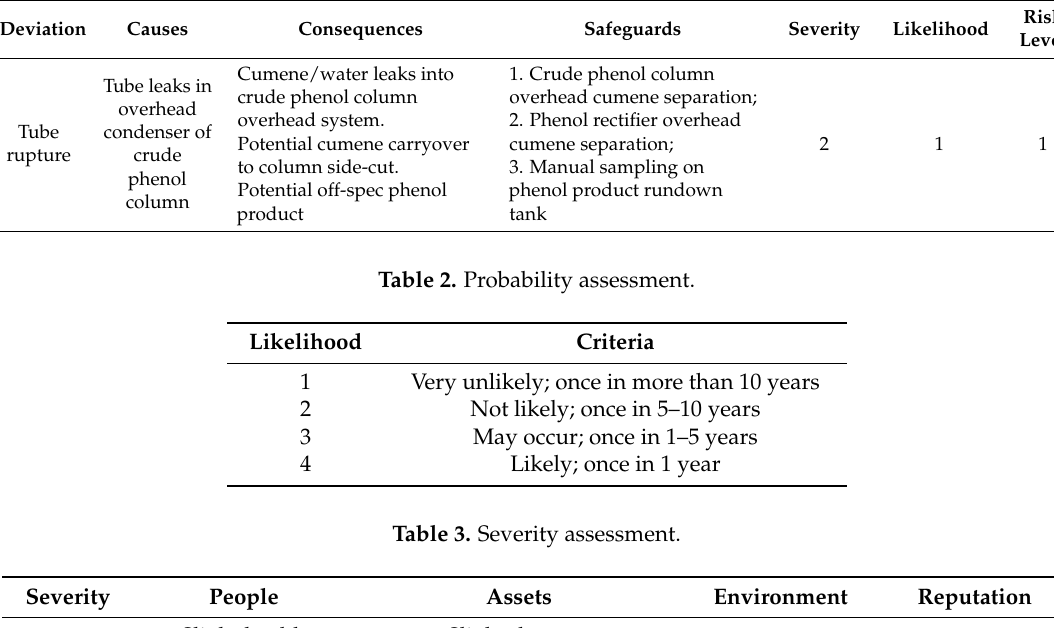
Table 1. PrHA result of the overhead condenser tube rupture case.